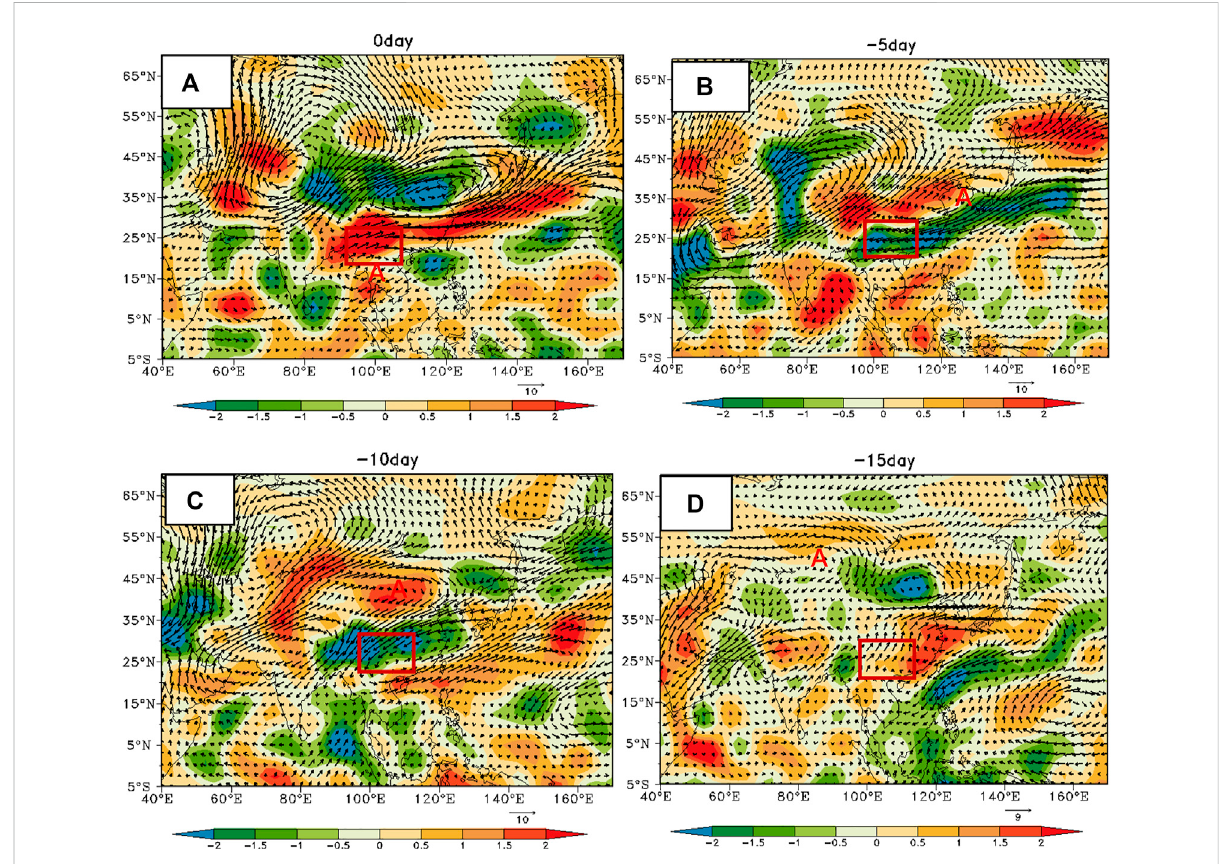
FIGURE 16 Evolutionofthelow-frequency(15 – 30 days)divergence(shading,unit:10 − 6 S − 1 )andwind(vector,unit:m/s) fi eldat200 hPafrom15 daysbefore the precipitation to 0 day after onset in Yunnan